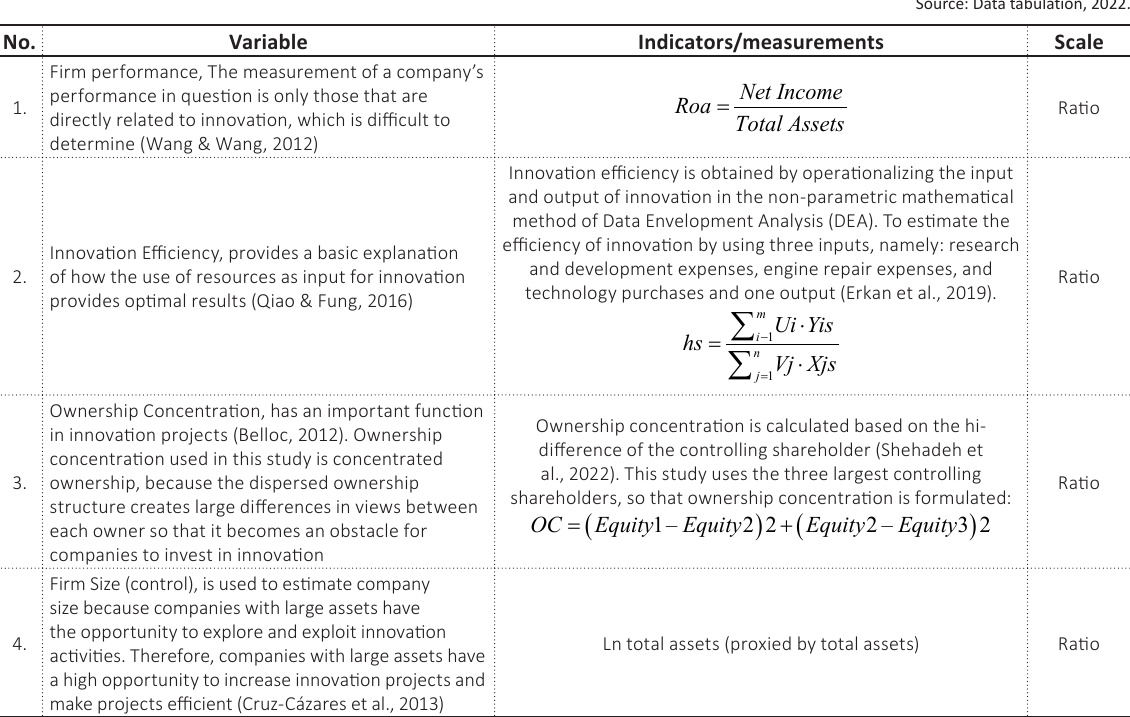
Table 1. Definition and measurement of research